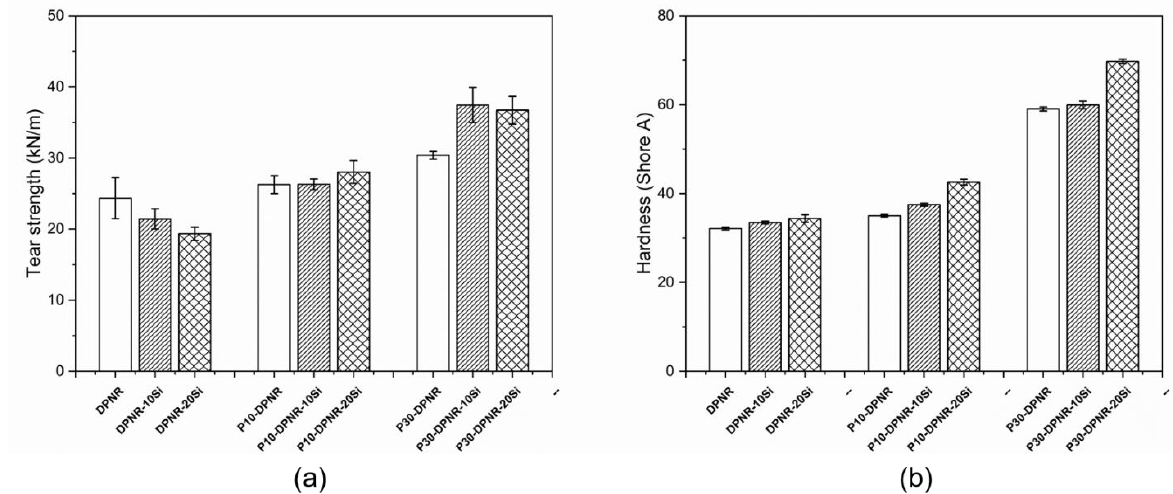
Figure 16. ( a ) Tear strength and ( b ) hardness of the silica-filled natural rubber